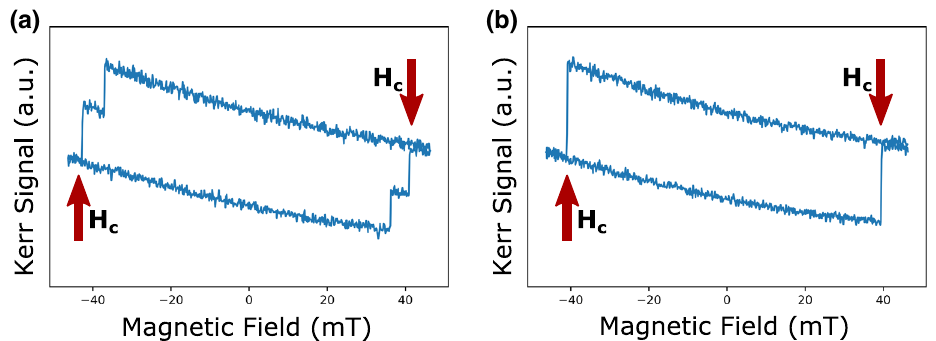
Figure 3. Illustration of a MOKE hysteresis loop with ( a ) multiple jumps ( b ) single jump.